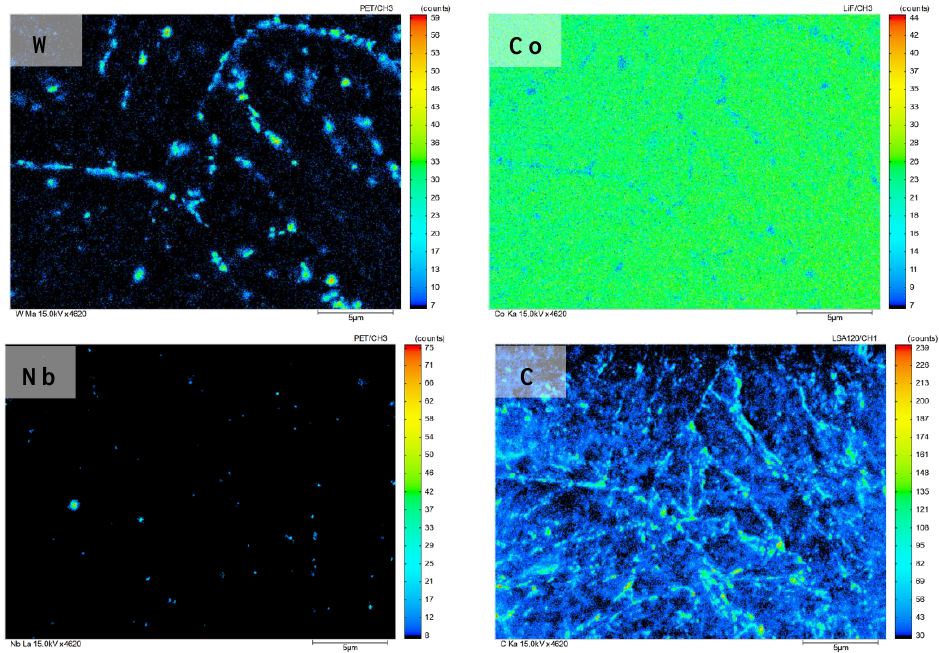
Figure 10. Analysis results of elements in 9Cr–3W–3Co heat-resistant steel.